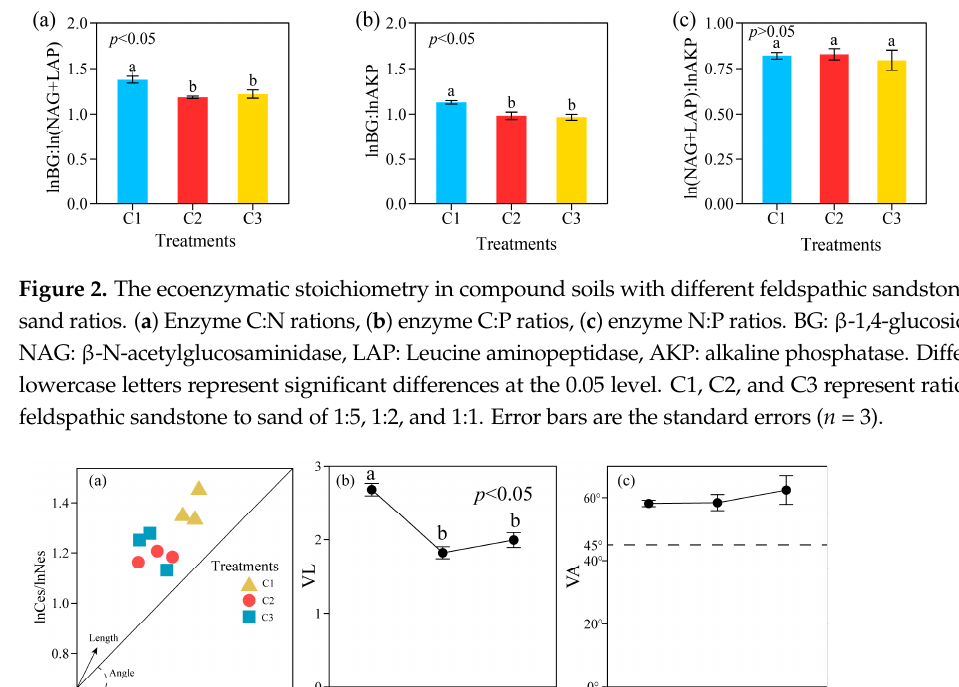
Figure 1. The extracellular enzyme activity in compound soils with different feldspathic sandstone- to-sand ratios. ( a ) BG, β -1,4-glucosidase, ( b ) NAG, β -N-acetylglucosaminidase, ( c ) LAP, Leucine aminopeptidase, ( d ) AKP, alkaline phosphatase. C1, C2, and C3 represent ratios of feldspathic sandstone to sand of 1:5, 1:2, and 1:1. Different lowercase letters represent significant differences at the 0.05 level. Error bars are the standard errors ( n = 3).